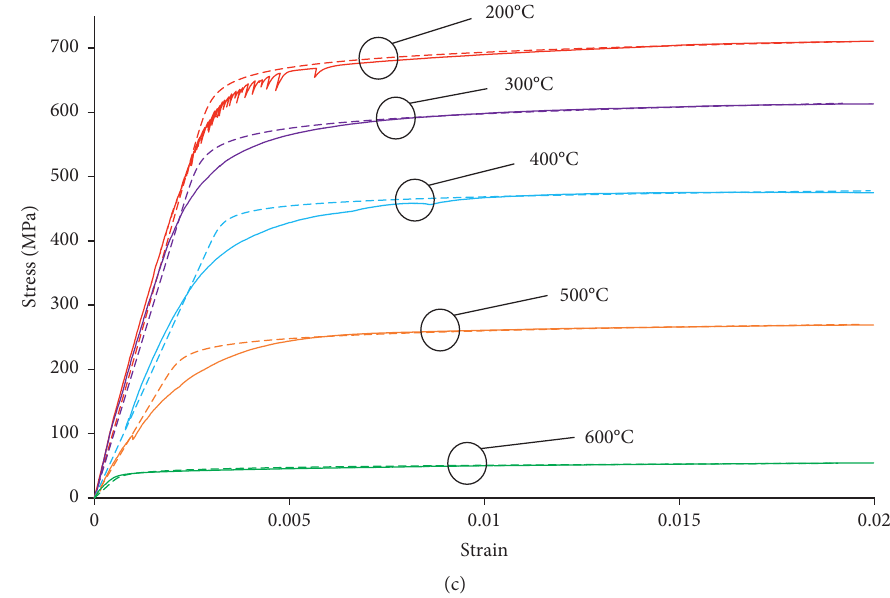
Figure 25: Stress-strain test curves (solid lines) and fitting curves (dashed lines). (a) S350 steels. (b) S420 steels. (c) G500